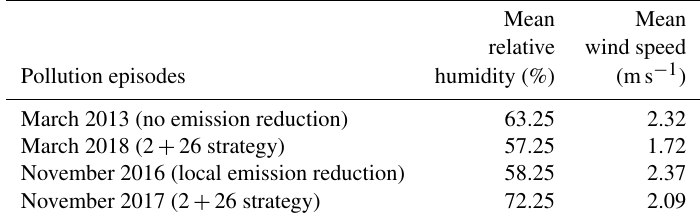
Table 3. Major meteorological conditions during the four pollution